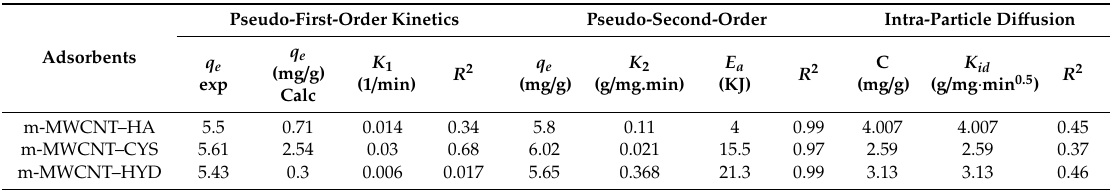
Table 3. Parameters for Ibu adsorption of kinetic models of pseudo-first-order, pseudo-second-order and intraparticle di ff usion on m-MWCNT–HA, m-MWCNT–CYS and m-MWCNT–HYD.